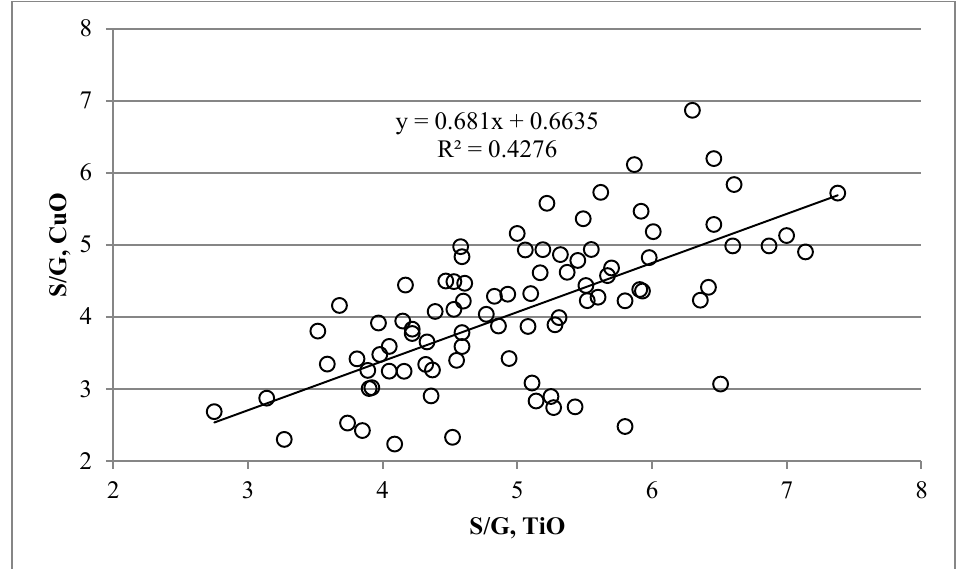
Figure 7. Comparisons of the S/G ratios obtained from the CuO (S/G, CuO) and thioacidolysis (S/G, TiO) analysis results. The wood material originated altogether from 88 trees of 22 different genotypes presenting natural variation in silver